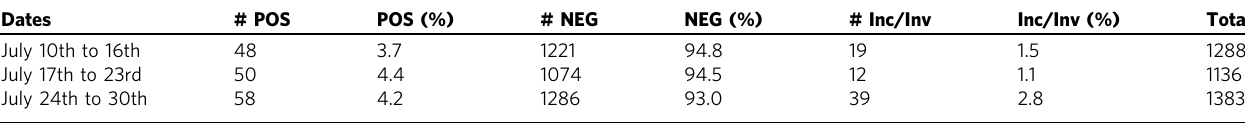
NEG negative, POS positive, Inc inconclusive, Inv invalid.